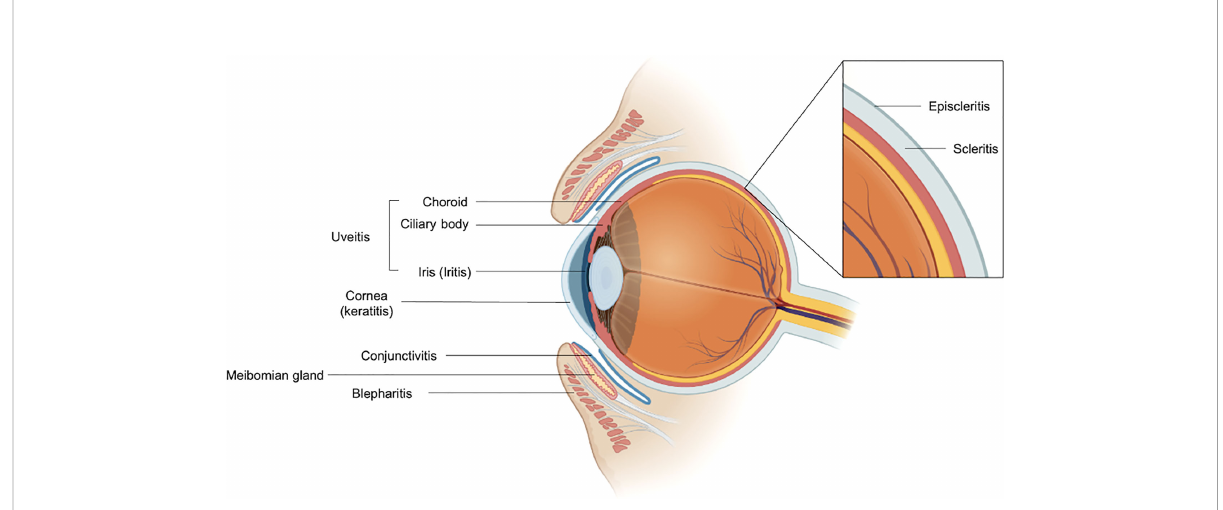
FIGURE 1 Anatomic organization of reported ocular immune-mediated adverse events. The meibomian gland is labeled for reference. Figure was generated using